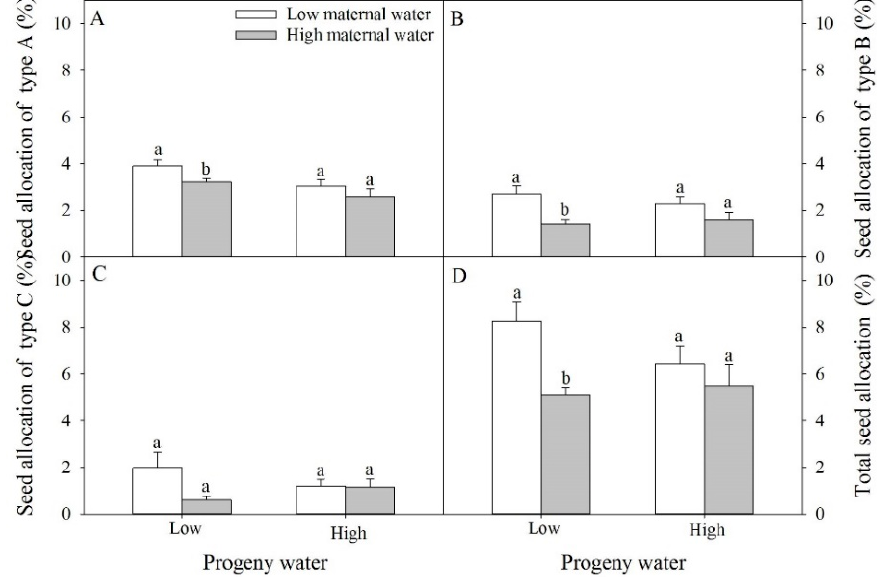
Figure 6. Effects of maternal and progeny water treatments on ( A ) seed allocation of type A, ( B ) seed allocation of type B, ( C ) seed allocation of type C, and ( D ) total seed allocation. Different lowercase letters represent significantly different means between plants with different maternal water treatments under the same progeny water treatment according to t -test ( p < 0.05).